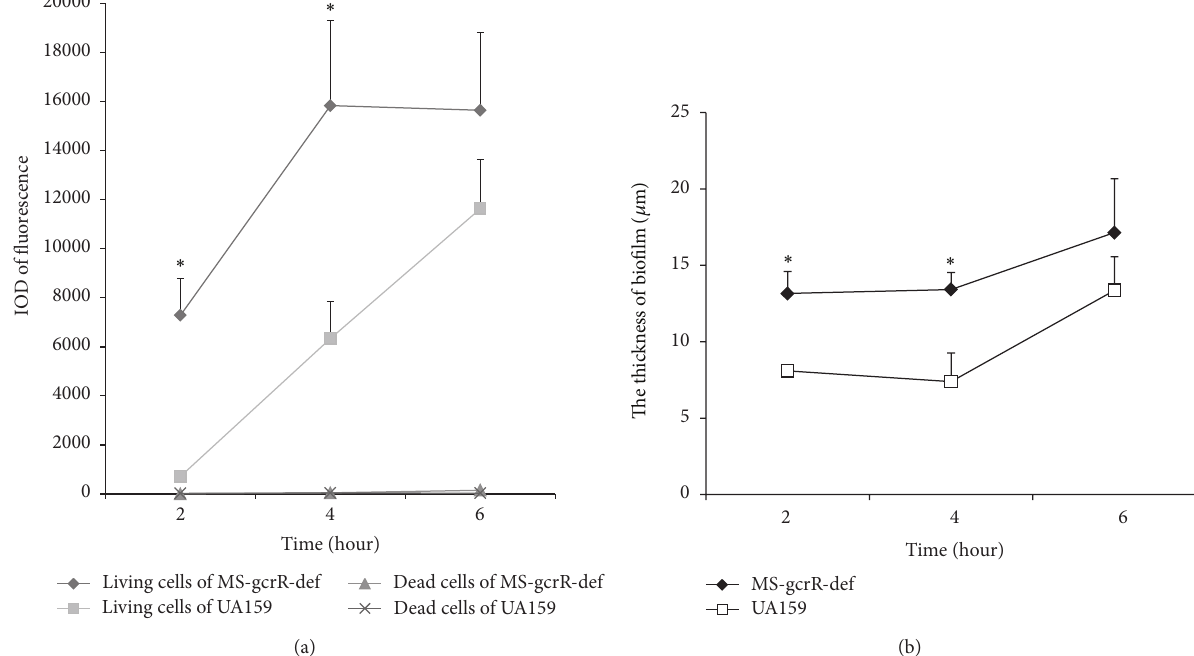
Figure 3: (a) IOD (integrated optical density) of the green and red fluorescence from biofilm cells. (b) Biofilm thickness. The Z section was used to record the biofilm thickness. Vertical lines were chosen randomly to analyze each image. The red and green fluorescence intensities of the dead cells and living cells, respectively, were also quantified using Image Pro-plus. ∗ Significant difference was found between green fluorescence of UA159 and MS-gcrR-def ( 𝑃 < 0.05 ).